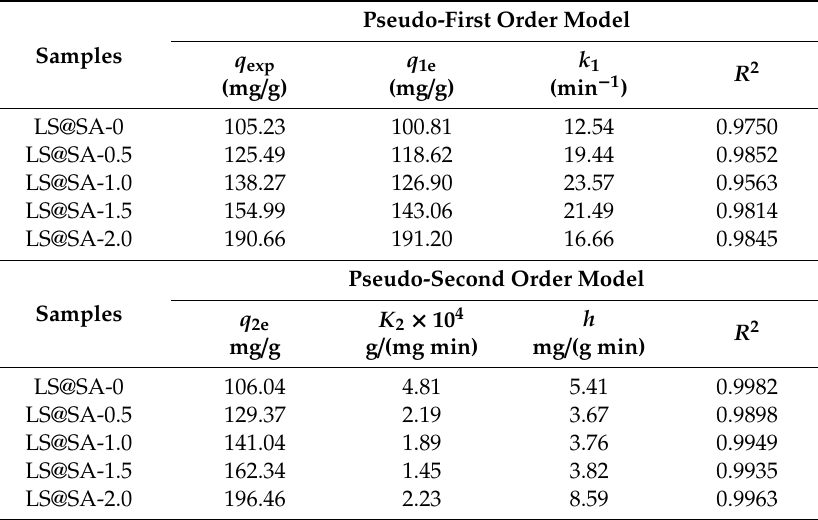
Table 1. Estimated adsorption kinetic parameters for MB adsorption.